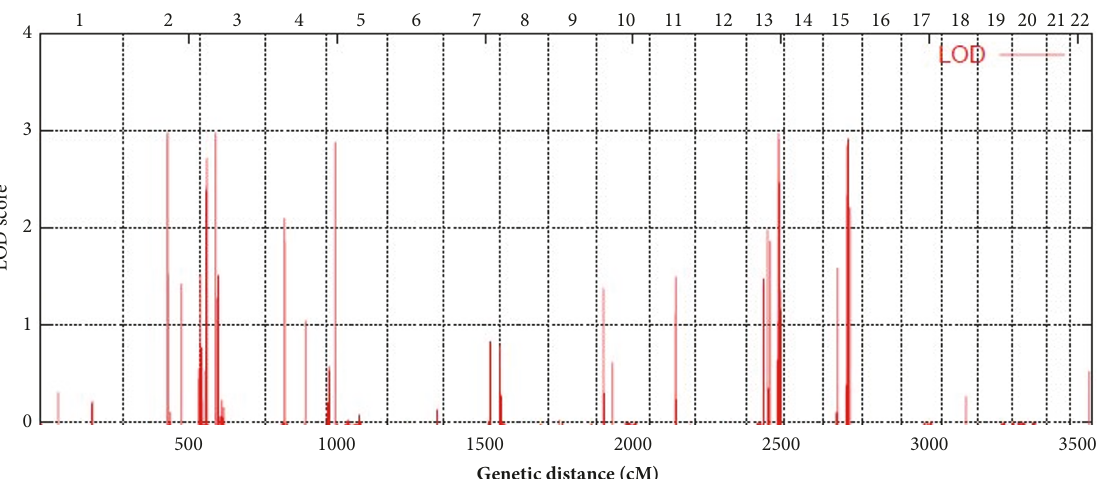
Figure 3: Plot of whole genome linkage analysis. Parametric multipoint LOD scores indicate linkage to three loci on 3p24.1-22.2, 13q33.2-34, and 15q22.2-25.1 with a maximum LOD score close to three.